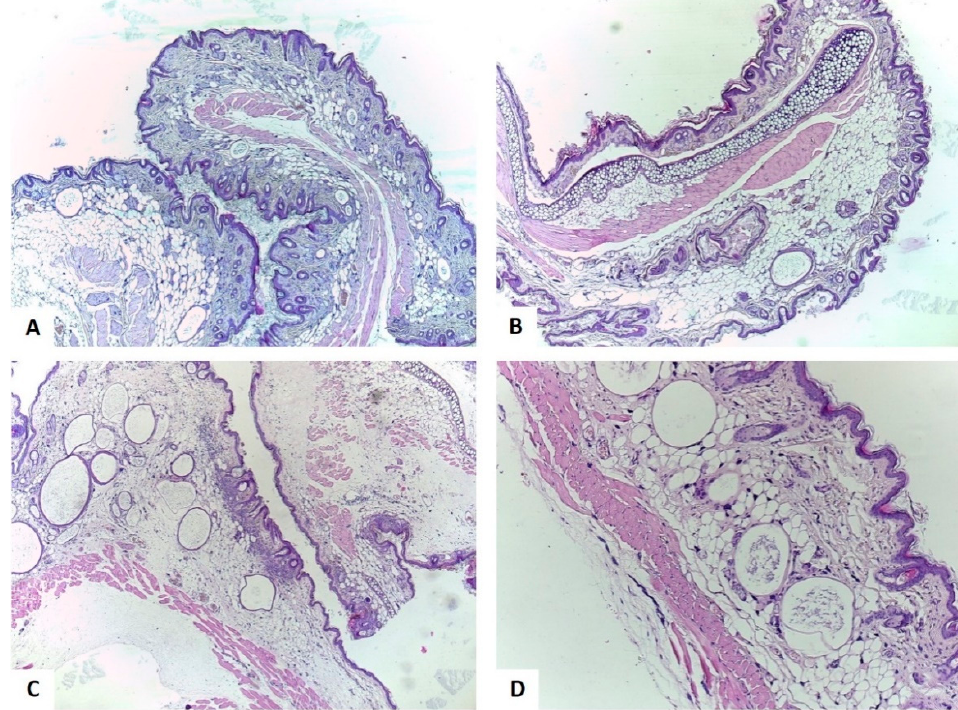
Figure 7. Histological aspects of the skin hematoxilin-eosine (H-E) stain, A : Control group – with no intervention, ob. 4×; B : Acetone group, ob. 4×; C : TPA group, ob. 4×; D : TPA + indomethacin group, ob. 10×. [29].